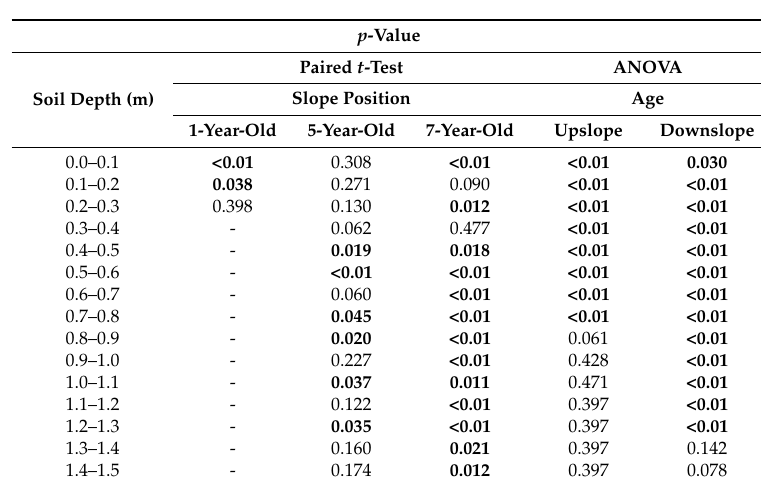
Table 6. Results of paired t -test and analysis of variance (ANOVA) for evaluating the effects of slope position and age on the root biomass across different ranges of soil